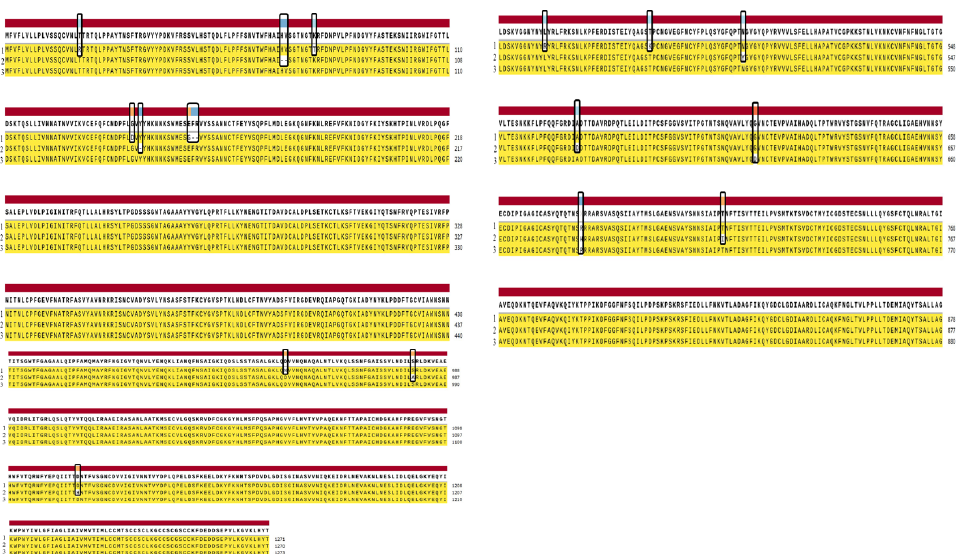
Figure 1. Schematic view of the contigs of the surface glycoprotein of (1) the Alpha variant (B.1.1.7) (UDQ41838.1), (2) the Delta variant (B.1.617.21) (UDU36746.1) of the SARS-CoV-2 with (3) the reference strain (Wuhan) (YP_009724390.1).